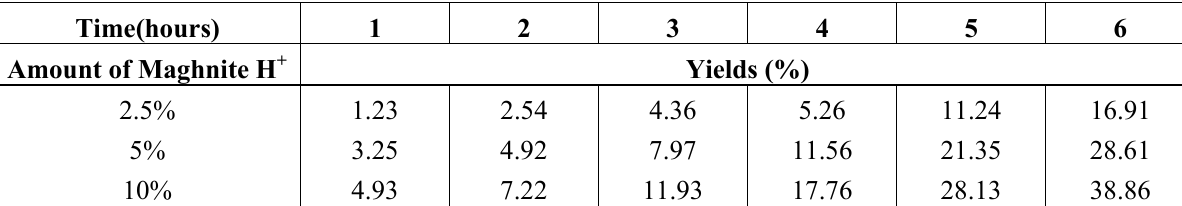
Table 3: Polymer yields with time for 10.75 mol/L of THF, 8.43 mol/L of maleic anhydride, 0.19 mol/L of acetic